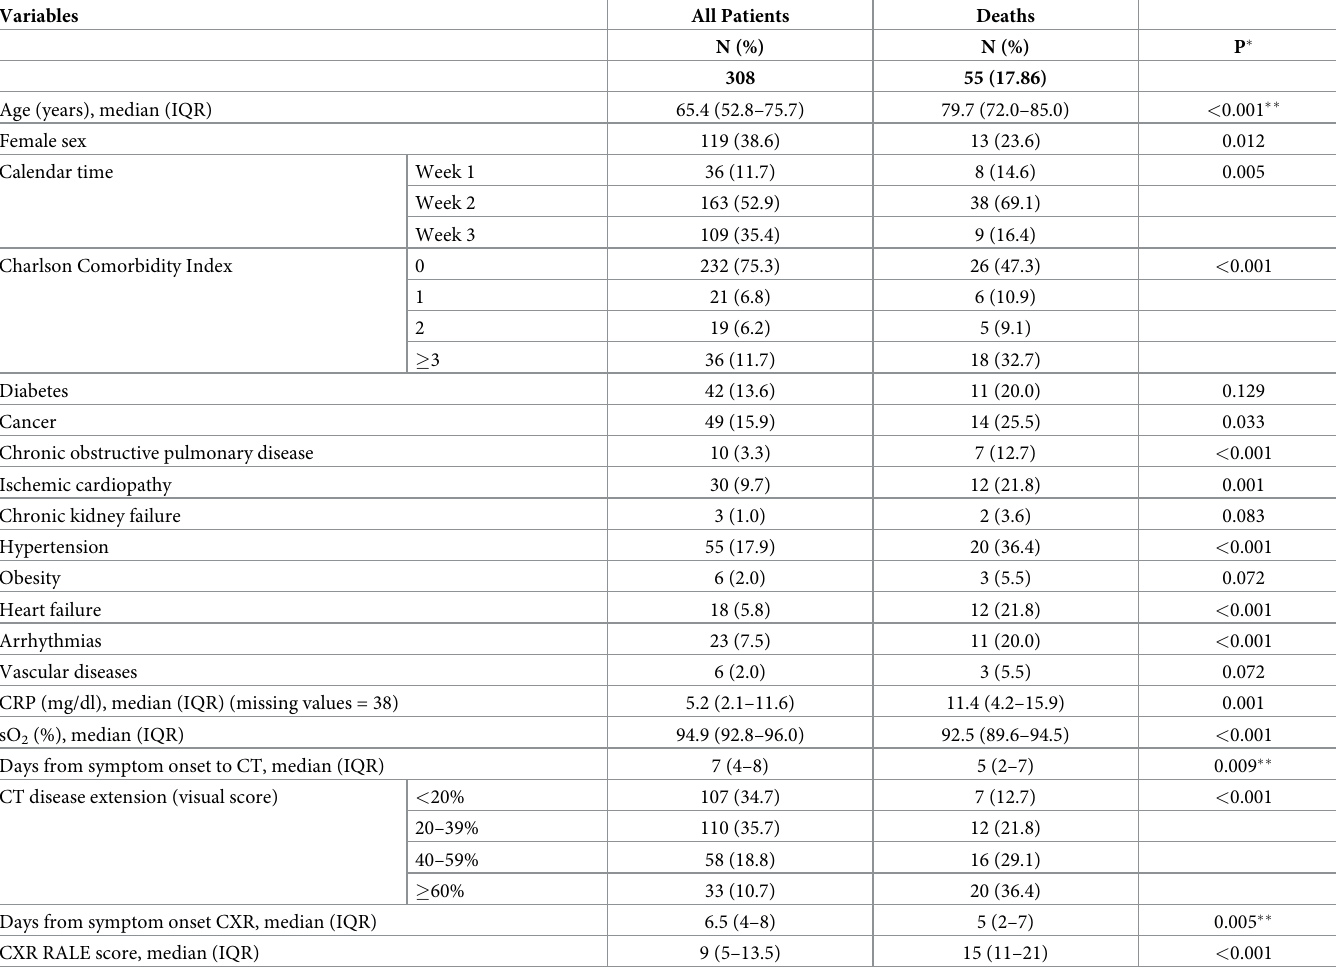
Table 1. Patients’ pre-existing condition, and clinical, laboratory, and CT findings at admission.